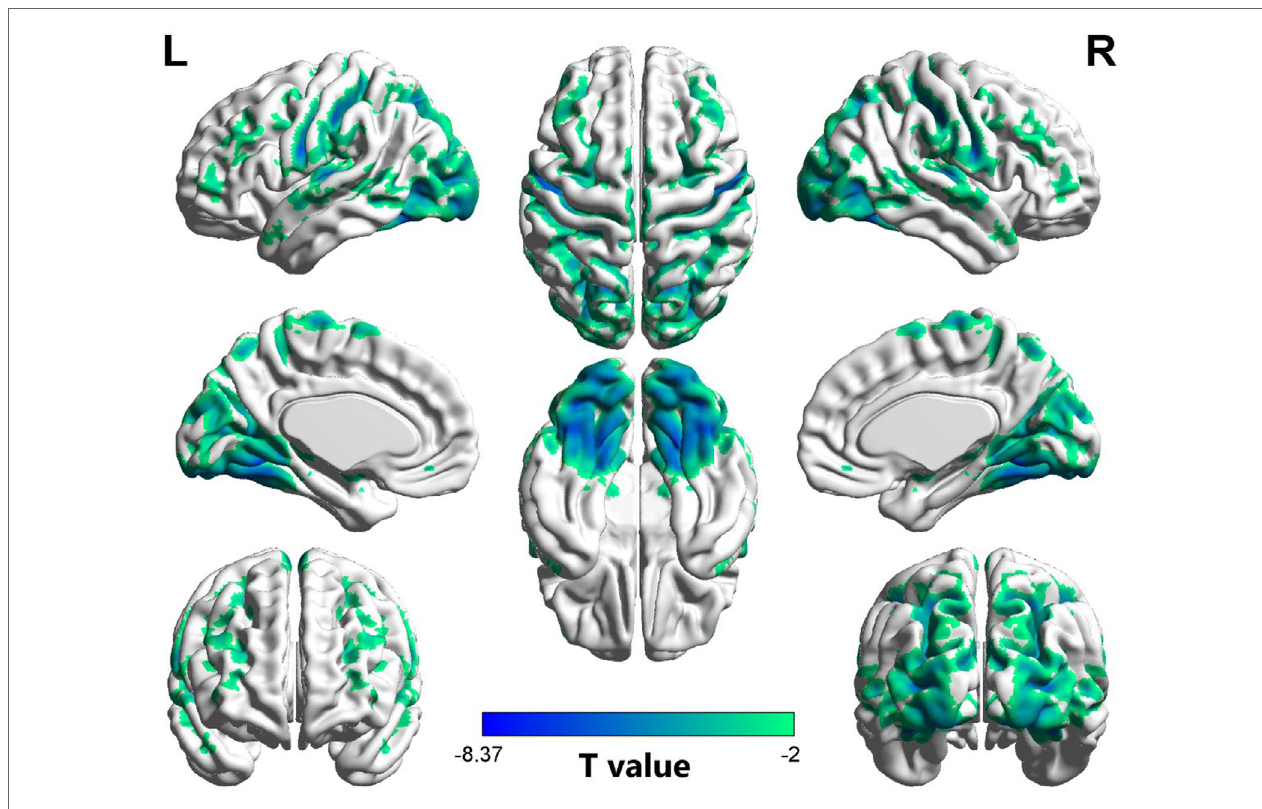
FIGURE 1 | Regions with decreased homotopic connectivity in obsessive–compulsive disorder (OCD) patients compared to healthy controls. L: left; R: